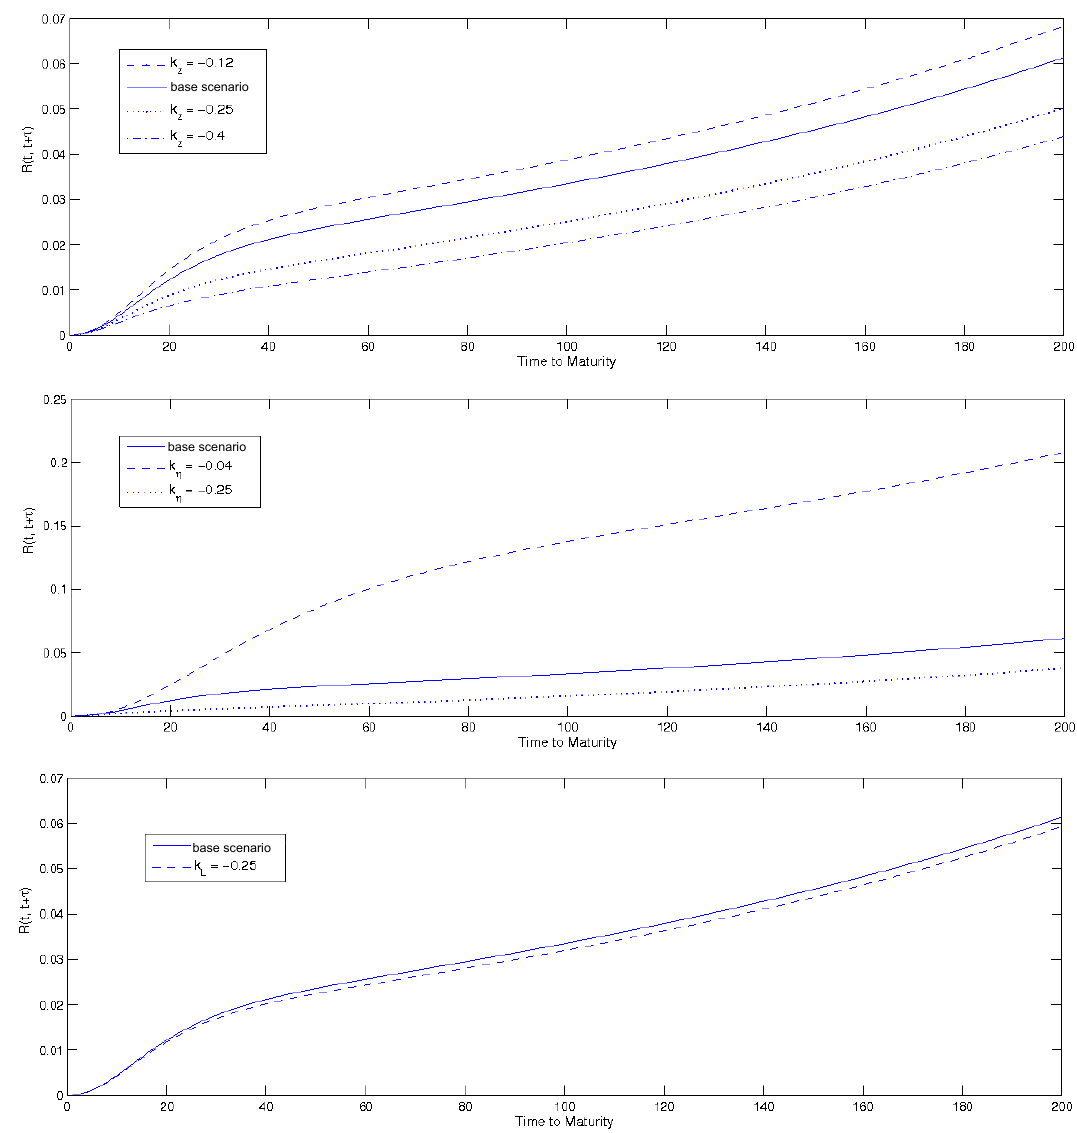
Figure 16. Spot yield to varying parameters k z , k η , and k L